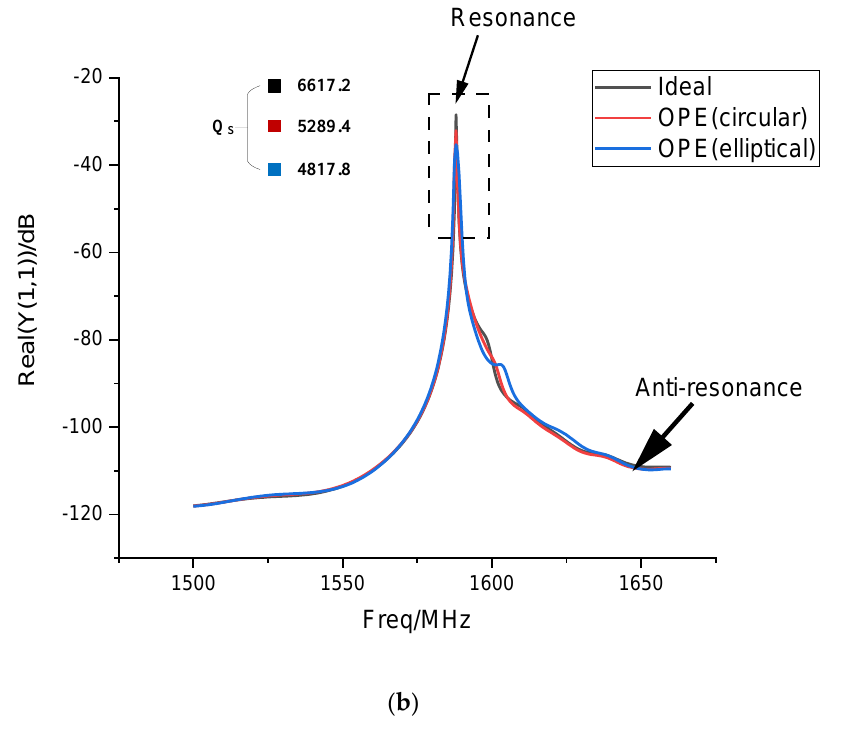
Figure 5. Effect of tail-end graphic distortion at the same gap size: ( a ) ideal pattern, circular pattern, elliptical pattern, (a = pitch); ( b ) simulation results based on ( a ). The dotted black box is a local magnification of the resonance frequency.